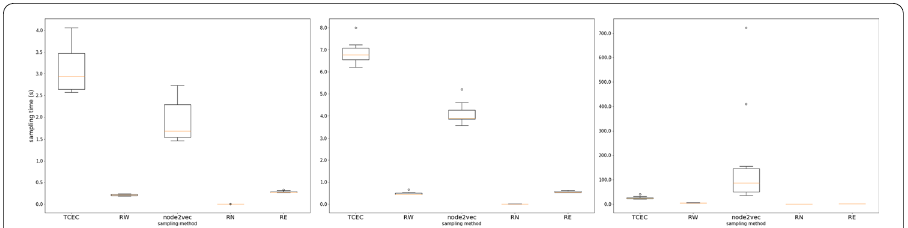
Fig. 10 Computational times for sampling 10% of the Epinions (left), Slashdot (center) and Stanford (right) datasets. System sizes are increasing from left to right (Epinions and Slashdot have ∼ 10 4 nodes, but the latter has almost twice the number of edges, Stanford has ∼ 10 5 nodes and ∼ 10 6 edges). In the first two EXP sampling is not represented, as it took an average, respectively, of ≈ 90 s and ≈ 400 s , and has not been performed for the last, due to excessive computational time. Boxplots represent 10 rounds of